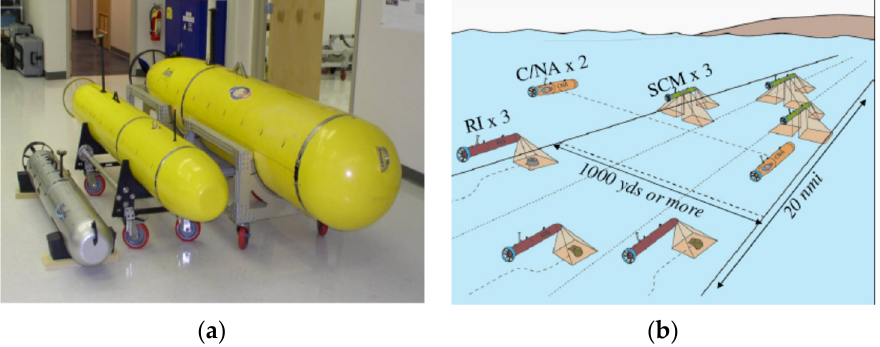
Figure 1. “CADRE” System. ( a ) Bluefin-9 and Bluefin-12. ( b ) Diagram of the “CADRE”